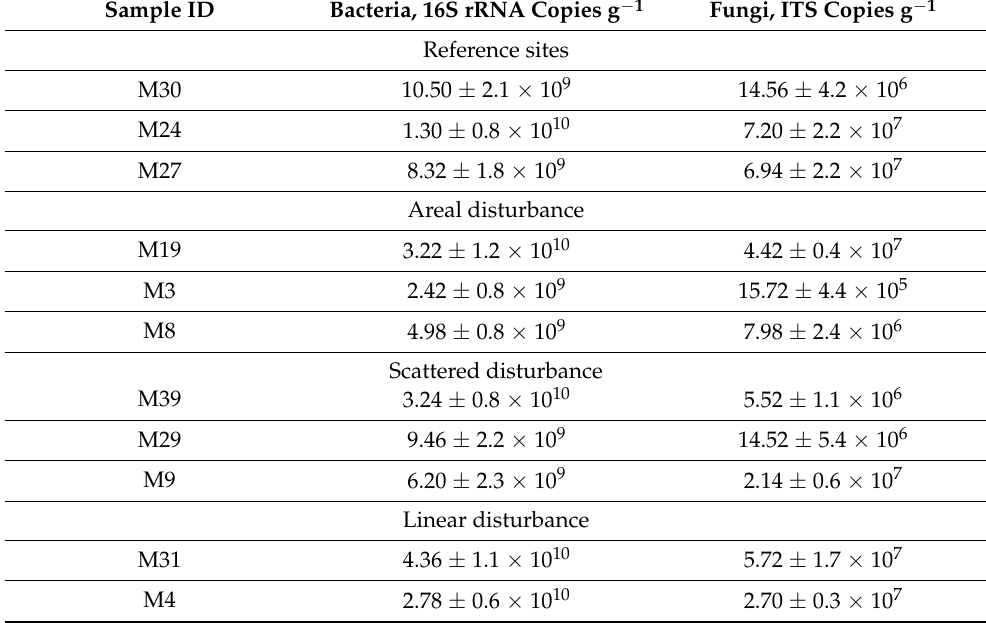
Table 4. The abundance of bacteria and fungi, as indicated by the number of 16S rRNA and ITS copies measured using quantitative PCR